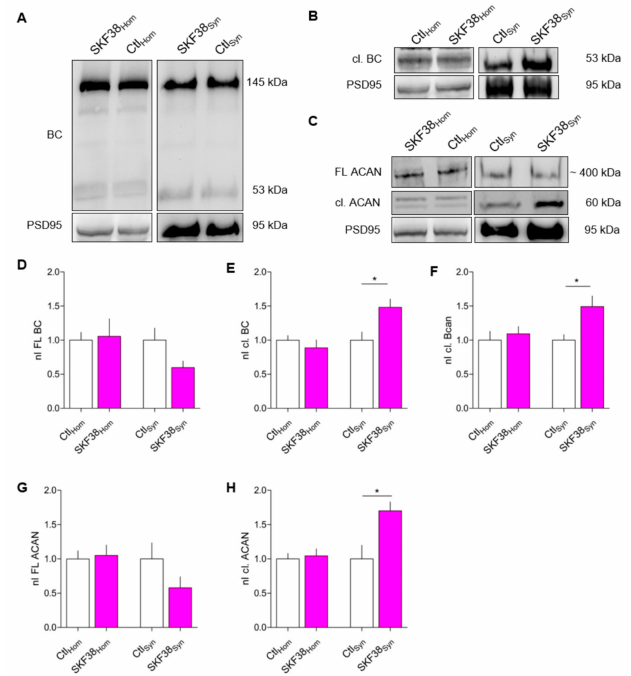
Figure 1. The ECM is altered in synaptosomal fractions of rat prefrontal cortex (PFC) after systemic activation of D1-like dopamine (DA) receptors in vivo. ( A ) Representative western blots showing the expression of brevican (BC) in homogenate (left) and synaptosomal fraction (right) with and w / o SKF38393 treatment. PSD95 illustrates the e ffi cient enrichment of synaptosomes. ( B ) Representative Western blots for the expression of cleaved BC (cl. BC) using the neo-epitope antibody Rb399 in the homogenate (left) and the synaptosomal fraction (right). PSD95 served as an indicator for e ffi cient fractionation. ( C ) Representative western blots for the expression of aggrecan (ACAN) and the cleaved fragment at a size of 60 kDa in the homogenate (left) and the synaptosomal fraction (right). PSD95 served as an indicator for e ffi cient fractionation. ( D ) The levels of full-length BC (FL BC) were unaltered in the homogenate of control and SKF-injected rats. In the synaptosomal fraction, FL BC was reduced after SKF38393 injection (homogenate: Ctl, 1 ± 0.1157, n = 4; SKF38, 1.056 ± 0.2574, n = 4; average ± SEM; unpaired t test; p = 0.8491; synaptosomes: Ctl, 1 ± 0.1745, n = 4; SKF38, 0.5980 ± 0.0961, n = 4; average ± SEM; unpaired t test; p = 0.0901) (nI FL BC = normalized intensity of full-length brevican). ( E ) The expression of cl. BC was unaltered in the homogenate after D1-like DA receptor activation, while in the synaptosomal fraction, the levels of cl. BC were significantly increased after SKF38393 treatment (homogenate: Ctl, 1 ± 0.0696, n = 4; SKF38, 0.8875 ± 0.116, n = 4; average ± SEM; unpaired t test; p = 0.4373; synaptosomes: Ctl, 1 ± 0.12, n = 4; SKF38, 1.481 ± 0.1221, n = 4; average ± SEM; unpaired t test; * p = 0.0308) (nI cl. BC = normalized intensity of cleaved brevican). ( F ) The expression of cl. BC as measured by the antibody Rb399 was unaltered in the homogenate, but significantly increased in the synaptosomal fraction of SKF38393-injected rats (homogenate: Ctl, 1 ± 0.1301, n = 4; SKF38, 1.092 ± 0.1098, n = 4; average ± SEM; unpaired t test; p = 0.8014; synaptosomes: Ctl, 1 ± 0.0826, n = 4; SKF38, 1.491 ± 0.1563, n = 4; average ± SEM; unpaired t test; * p = 0.032) (nI cl. BC = normalized intensity of cleaved brevican). ( G ) Full-length aggrecan (FL ACAN) was unaltered in the homogenate, while it was slightly but not significantly decreased in the synaptosomal fraction after D1-like DA receptor activation (homogenate: Ctl, 1 ± 0.1176, n = 4; SKF38, 1.05 ± 0.1511, n = 4; average ± SEM; unpaired t test; p = 0.8014; synaptosomes: Ctl, 1 ± 0.2342, n = 4; SKF38, 0.5798 ± 0.1598, n = 4; average ± SEM; unpaired t test; p = 0.1889) (nI FL Aggr = normalized intensity of full-length aggrecan). ( H ) The expression of cleaved ACAN (cl. ACAN) was unaltered in the homogenate, while in the synaptosomal fraction the levels were significantly increased after D1-like DA receptor activation (homogenate: Ctl, 1 ± 0.0815, n = 4; SKF38, 1.044 ± 0.1017, n = 4; average ± SEM; unpaired t test; p = 0.7458; synaptosomes: Ctl, 1 ± 0.1985, n = 4; SKF38, 1.7 ± 0.1317, n = 4; average ± SEM; unpaired t test; * p = 0.0261) (nI cl. Aggr = normalized intensity of cleaved